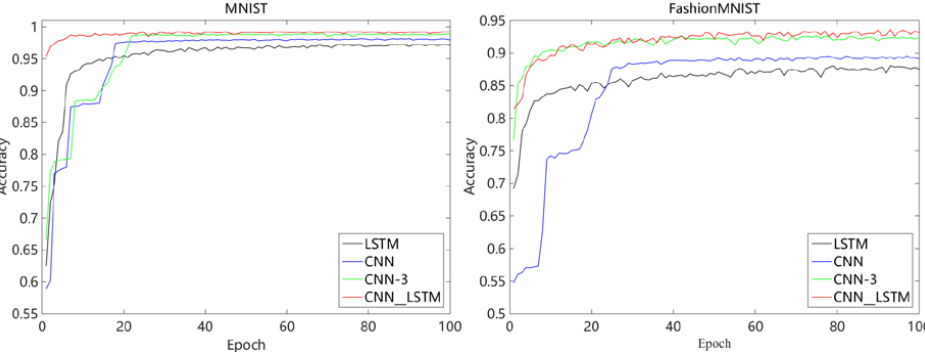
Figure A1. The representation of different algorithms on MNIST and FashionMNIST datasets. Table A1. The recognition accuracy of each algorithm on the test sets and the recognition time of a single image.